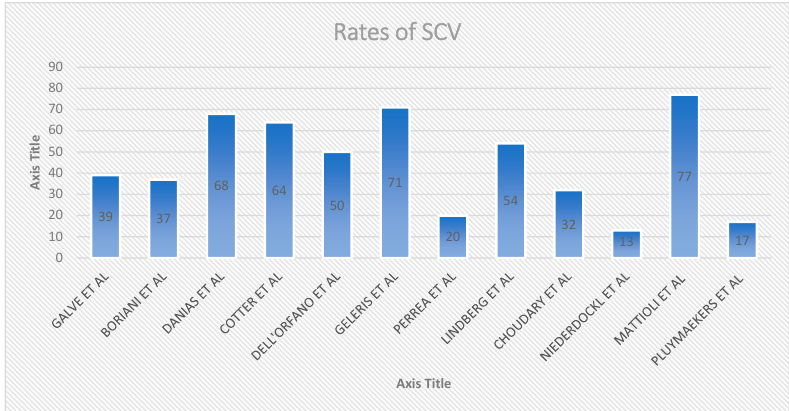
Figure 1. Different SCV% among studies . Table 1. Studies evaluating the rate and determinants of spontaneous cardioversion of atrial fibrillation.